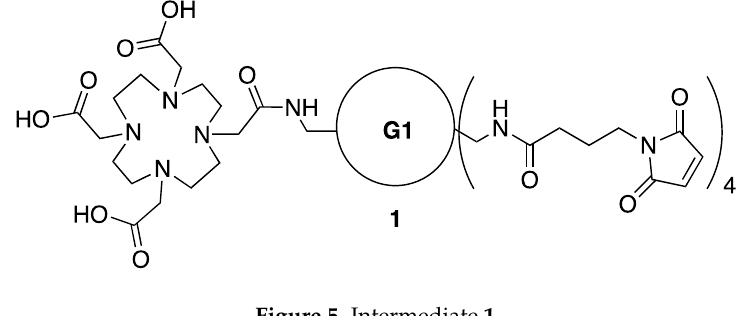
Figure 3. Intermediate 1 . Figure 5. Intermediate 1 .